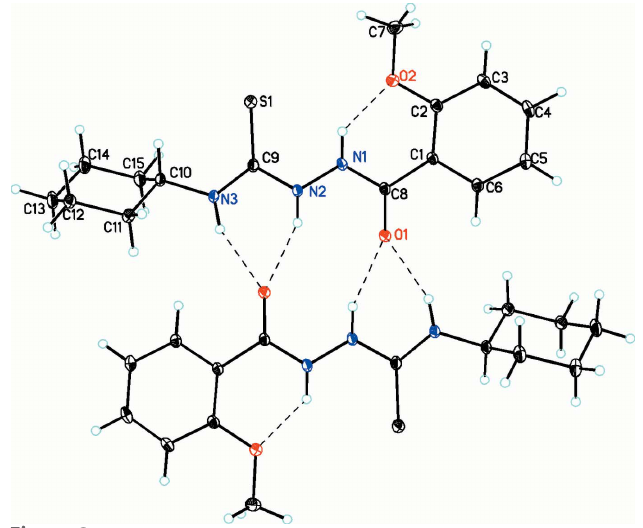
Figure 2 A view of the N—H (cid:2)(cid:2)(cid:2) O hydrogen-bonding interactions (dashed lines; Table l) involving the same acceptor atom, forming an inversion dimer. Unlabelled atoms are related to labelled ones by the symmetry operation